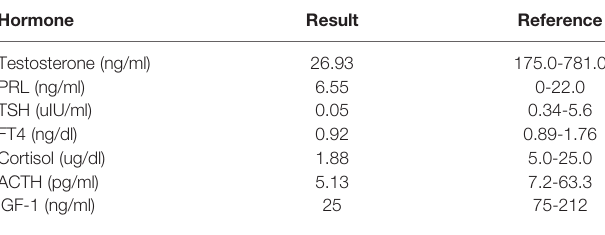
TABLE 1 | Initial hormonal evaluation, indicating hypoadrenocorticism and hypogonadism of the patient. Hormone